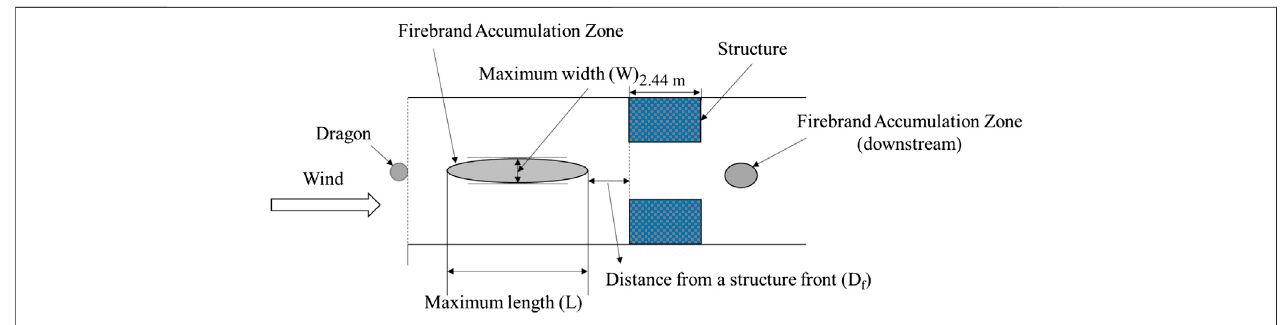
FIGURE 7 | Schematic of fi rebrand accumulation patterns and their